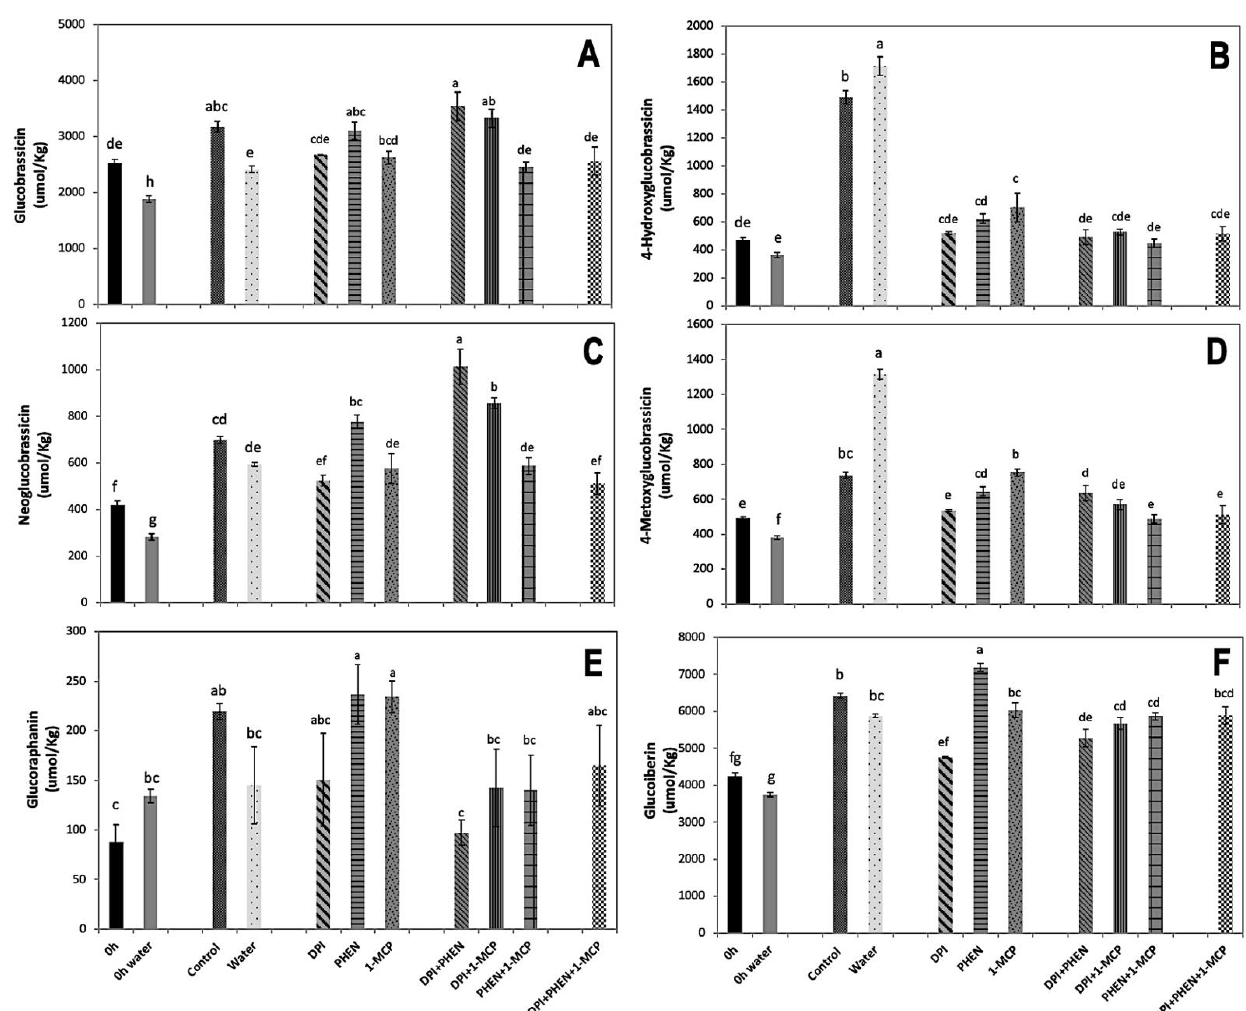
Figure 3. Effect of stress-signaling molecule inhibitors on the wound-induced accumulation of individual GS in broccoli. Glucobrassicin ( A ); 4-hydroxyglucobrassicin ( B ); neoglucobrassicin ( C ); 4-metoxyglucobrassicin ( D ); glucoraphanin ( E ); glucoiberin ( F ). Glucosinolates were quantified in broccoli chops before and after 21 h of storage. Values represent the mean of three replicates ± standard error of the mean. Concentrations are reported on a dry weight basis. Bars with different letters (a, b, c, d, e, f, and g) indicate statistical difference by the LSD test ( p < 0.05). Abbreviations: diphenyleneiodonium chloride (DPI), phenidone (PHEN), and 1-methylcyclopropene (1-MCP).